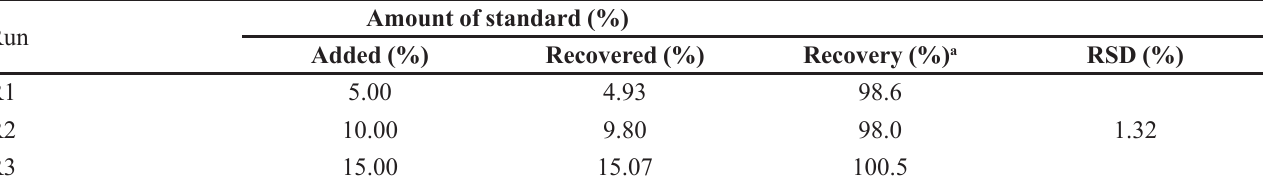
TABLE IV - Accuracy of the microbiological assay of CHX digluconate Run